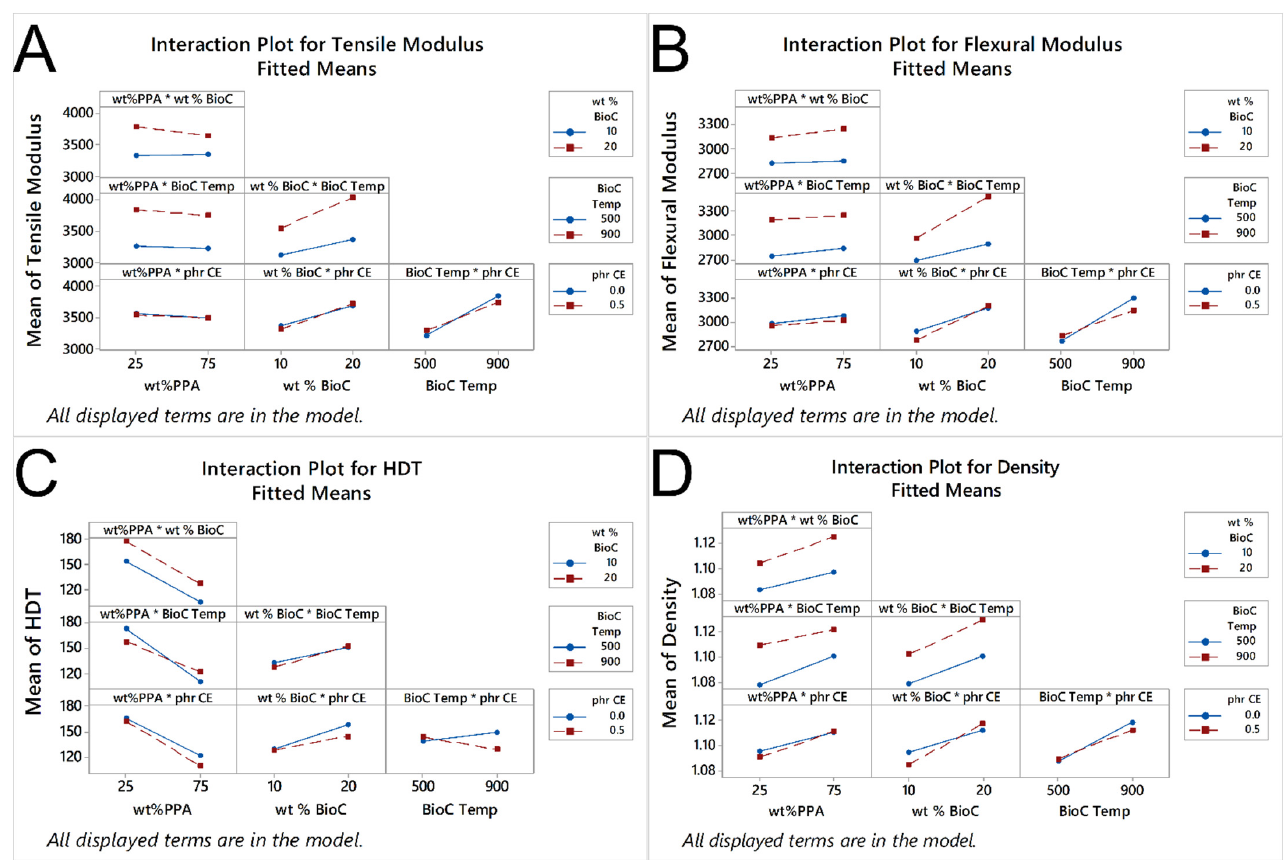
Figure 4. Main effects that the four different factors, wt% PPA, wt% BioC, the temperature of pyrolysis of BioC and the presence of chain extender, have on ( A ) tensile modulus, ( B ) flexural modulus, ( C ) HDT and ( D ) density.